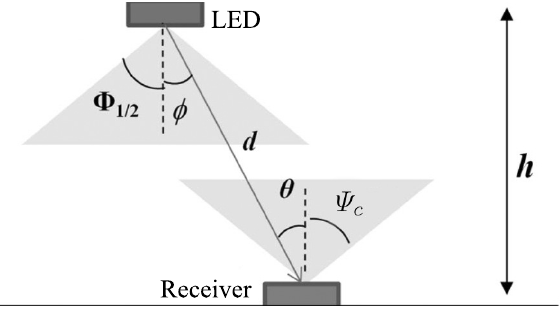
Figure 8. Light transmission between LED and